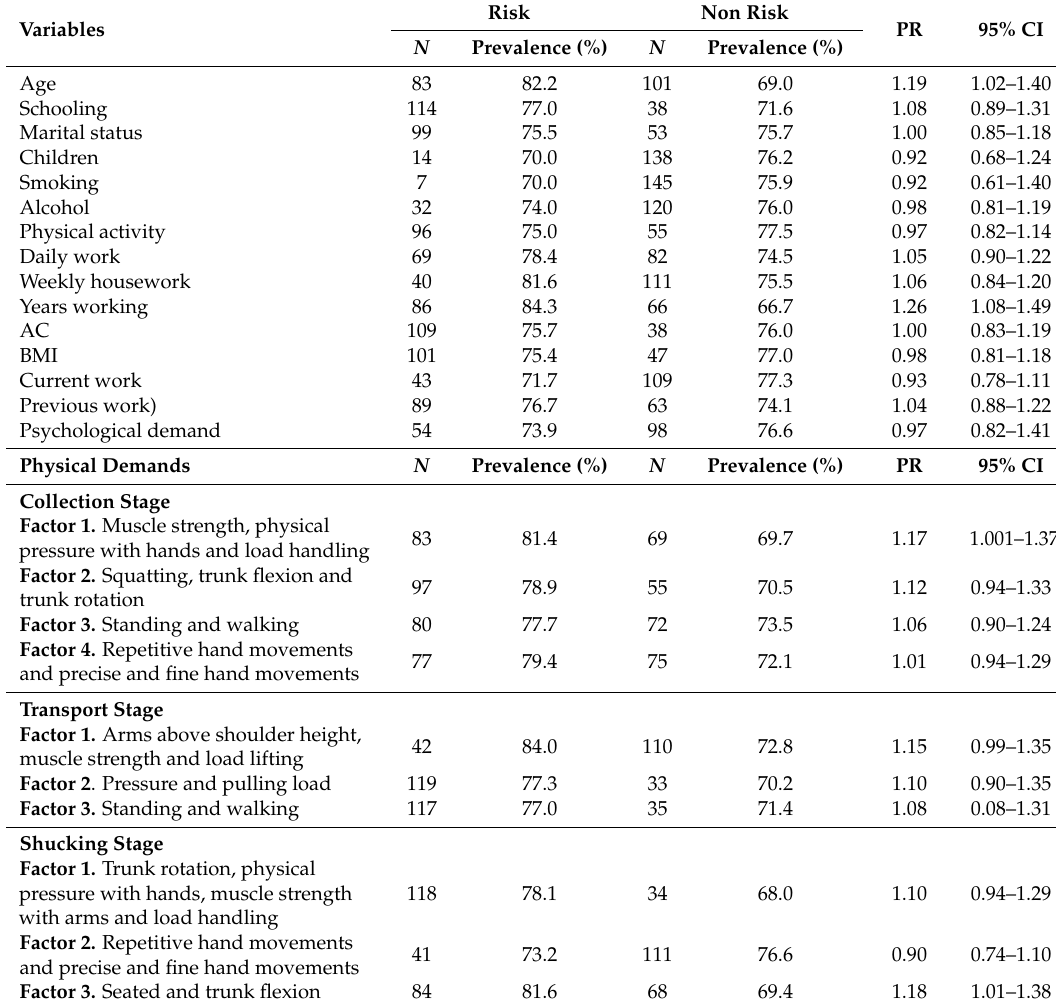
Table 4. Univariate analysis of the prevalence ratio between lower back MSD, socio-demographic variables, lifestyle and occupational habits, psychosocial and physical demands ( N = 209).